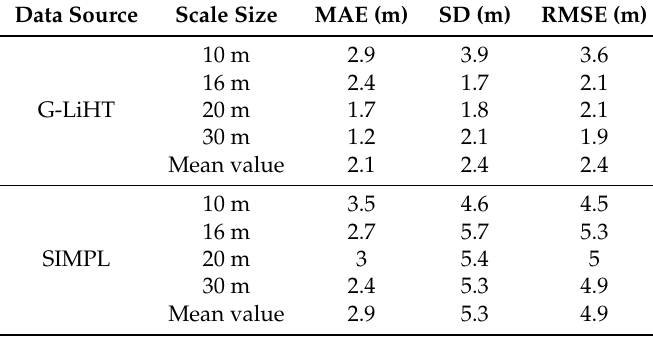
Table 3. Result of validation using the Howland stem map. MAE is mean absolute error, SD is the standard deviation, and RMSE is the root mean square